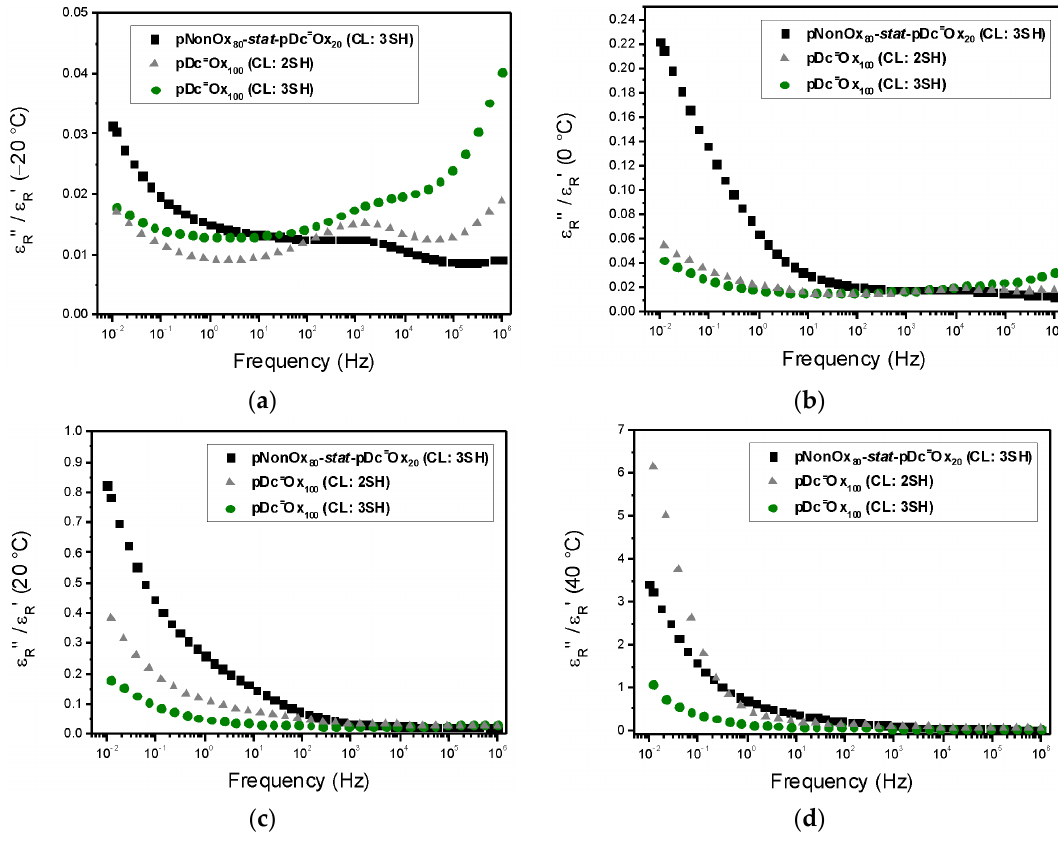
Figure 3. Frequency-dependent loss factors of pNonOx 80 - stat -pDc = Ox 20 (CL:3SH), pDc = Ox 100 (CL:2SH), and pDc = Ox 100 (CL:3SH) at − 20 °C ( a ), 0 °C ( b ), 20 °C ( c ) and 40 °C ( d ). Table 4. Loss factors of the poly(2-oxazoline)-based networks at 50 Hz.